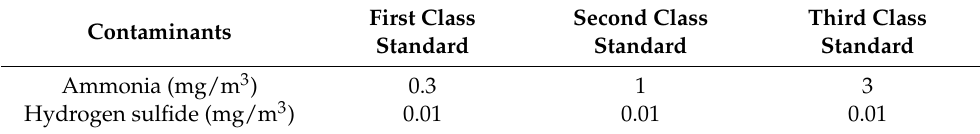
Table 1. Concentration standards for ammonia and hydrogen sulfide in public toilets.